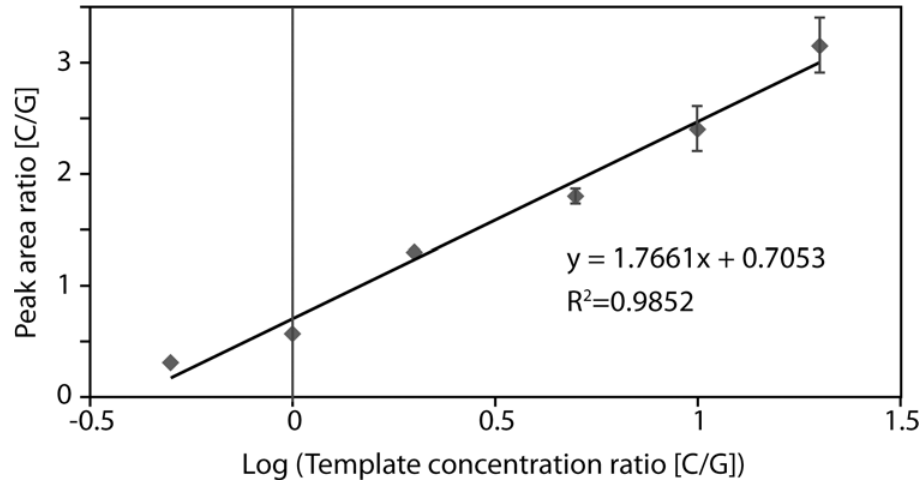
Fig 2. Calibration curve established to calculate the initial miRNA concentration in the competitive PCR reaction.